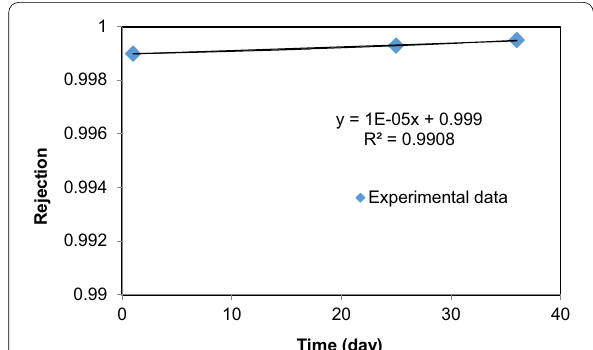
Fig. 1 Comparison between experimental data and model predicted rejection ratio